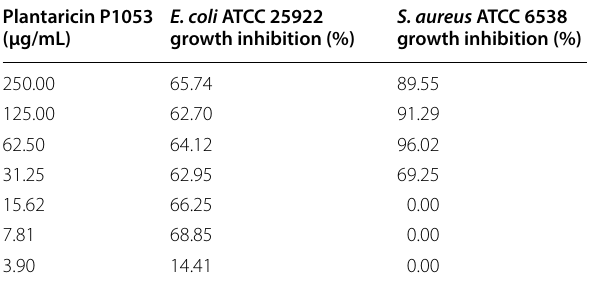
Table 2 Minimum inhibitory concentration (MIC) of the growth measured by plantaricin P1053 isolated from L. plantarum strain PBS067 against E. coli ATCC 25922 and S. aureus ATCC 6538